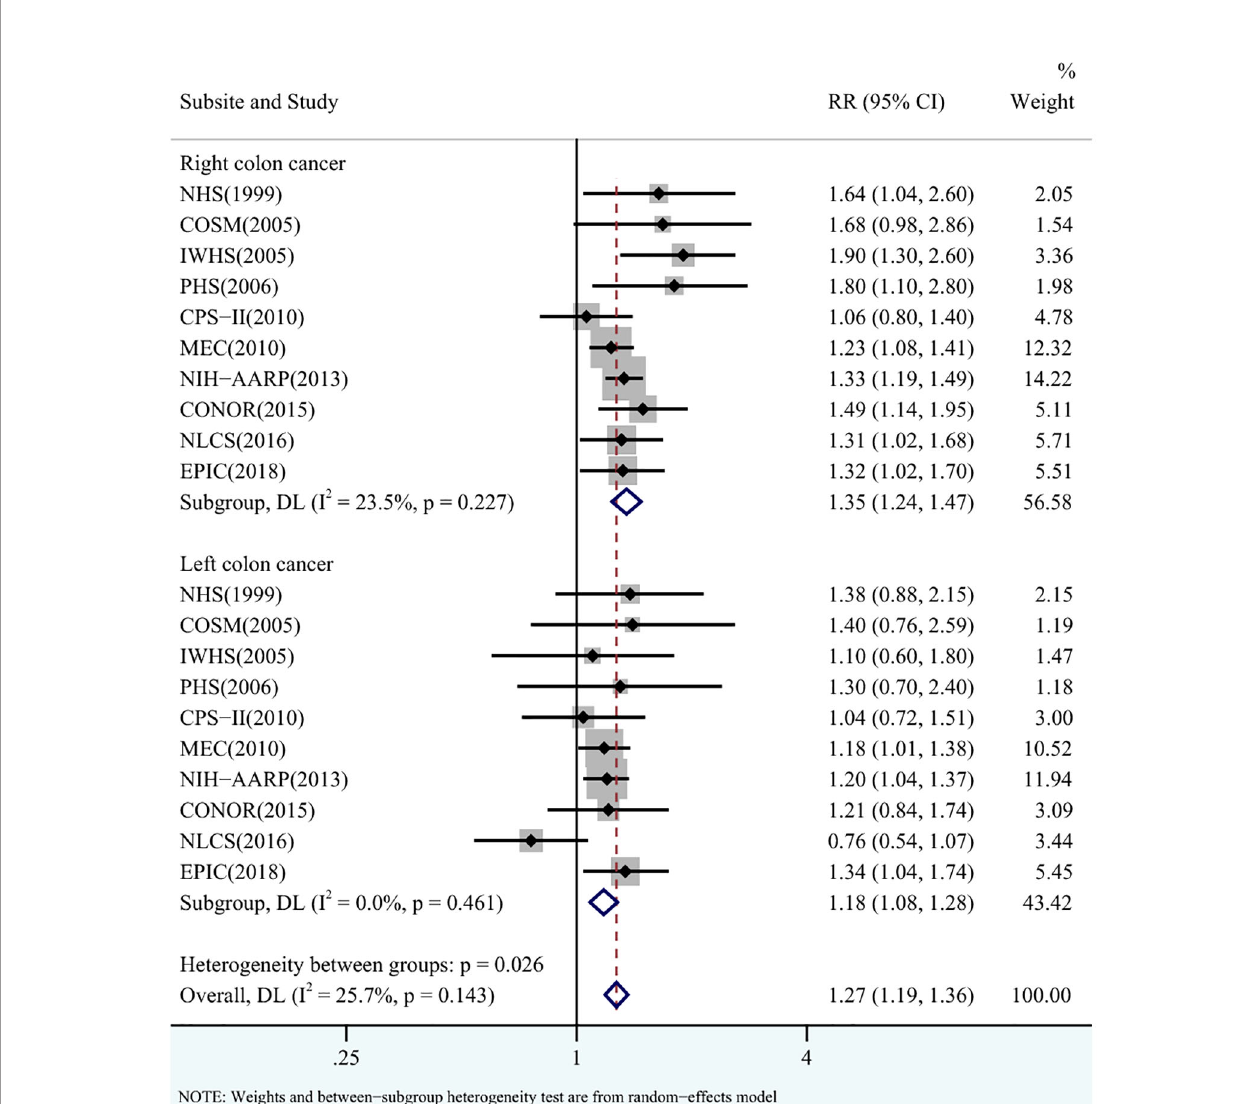
FIGURE 2 | Pooled relative risks (RRs) for the association between diabetes and the risks of right-sided colon cancer (RCC) and left-sided colon cancer